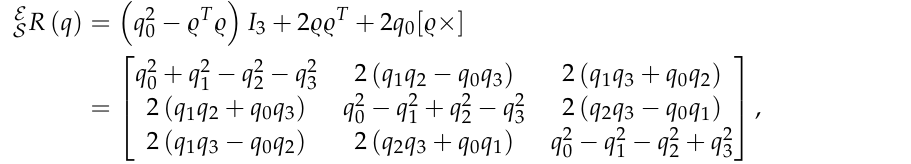
) and sensor frame ( E